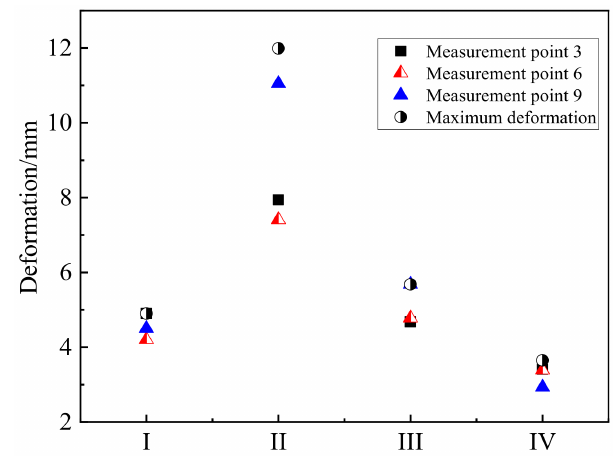
Figure 15. Hamburg wheel tracking deformation.